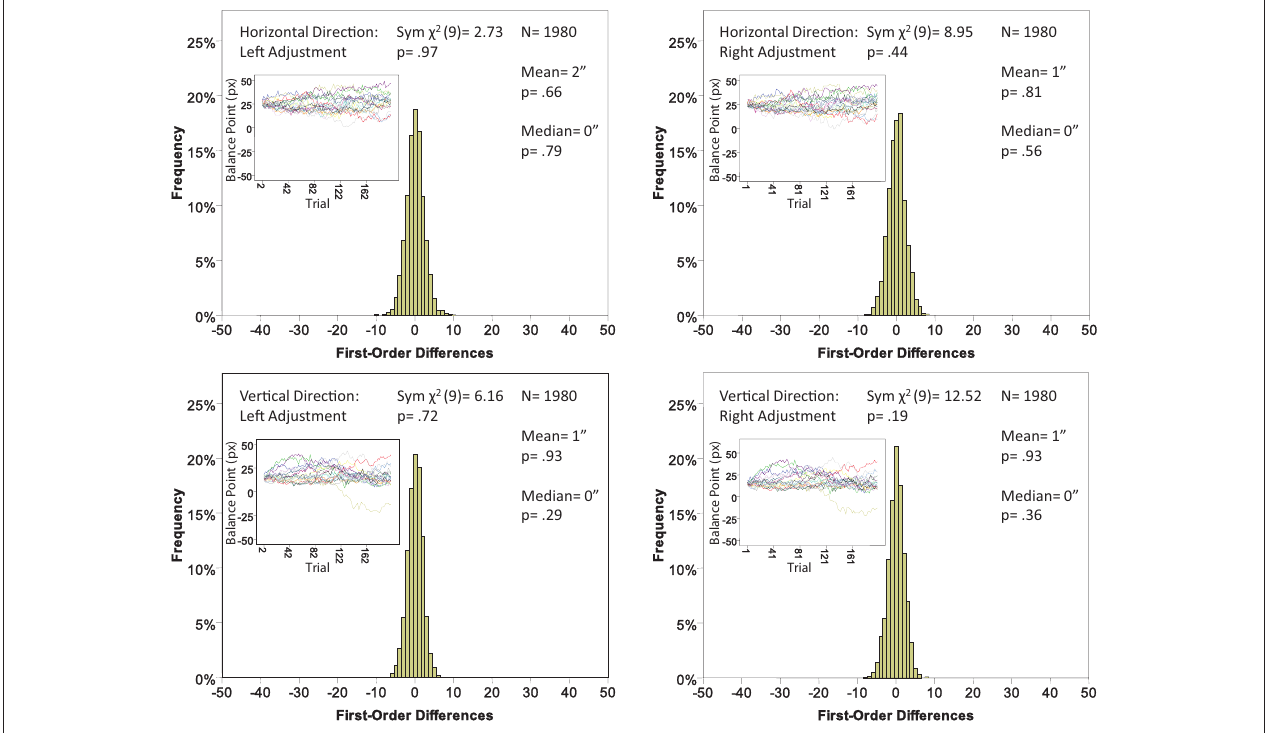
Figure 7 | Histograms of the first-order differences ( ∆ ’s) for the location experiment, participant LP. The insets show the time series of the matching adjustments from which the ∆ ’s were computed. Each panel contains the mean and the median of the corresponding ∆ (in sec arc), with the p -values for the hypotheses that the population mean and median are 0, as well as the χ 2 (df = 9) and the p -value for the symmetry test described in the